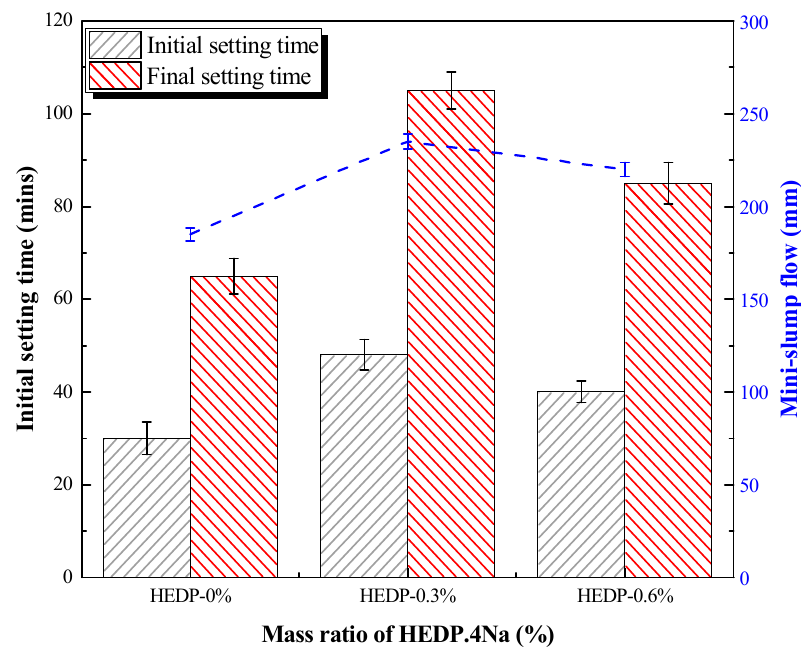
Figure 2. Effect of HEDP.4Na on setting time and mini-slump flow.